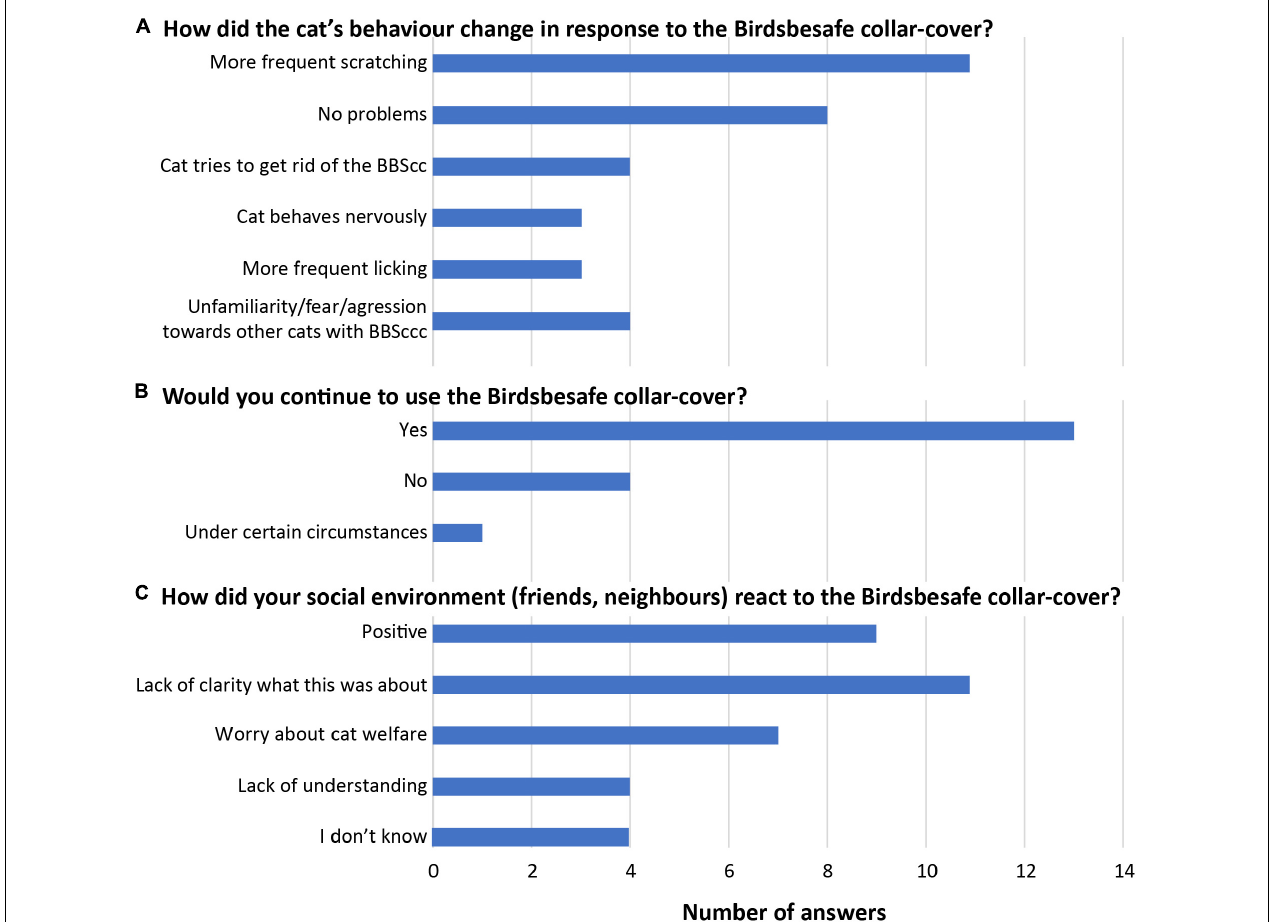
FIGURE 4 | Results of cat behavior (A) and cat owner (B,C) polls. (A) Answers from the 26 households that successfully finished the study (more than 1 answer per household possible). (B,C) Answers from a final survey that was filled in by 18 participants, including some which terminated the survey prematurely, and with multiple answers